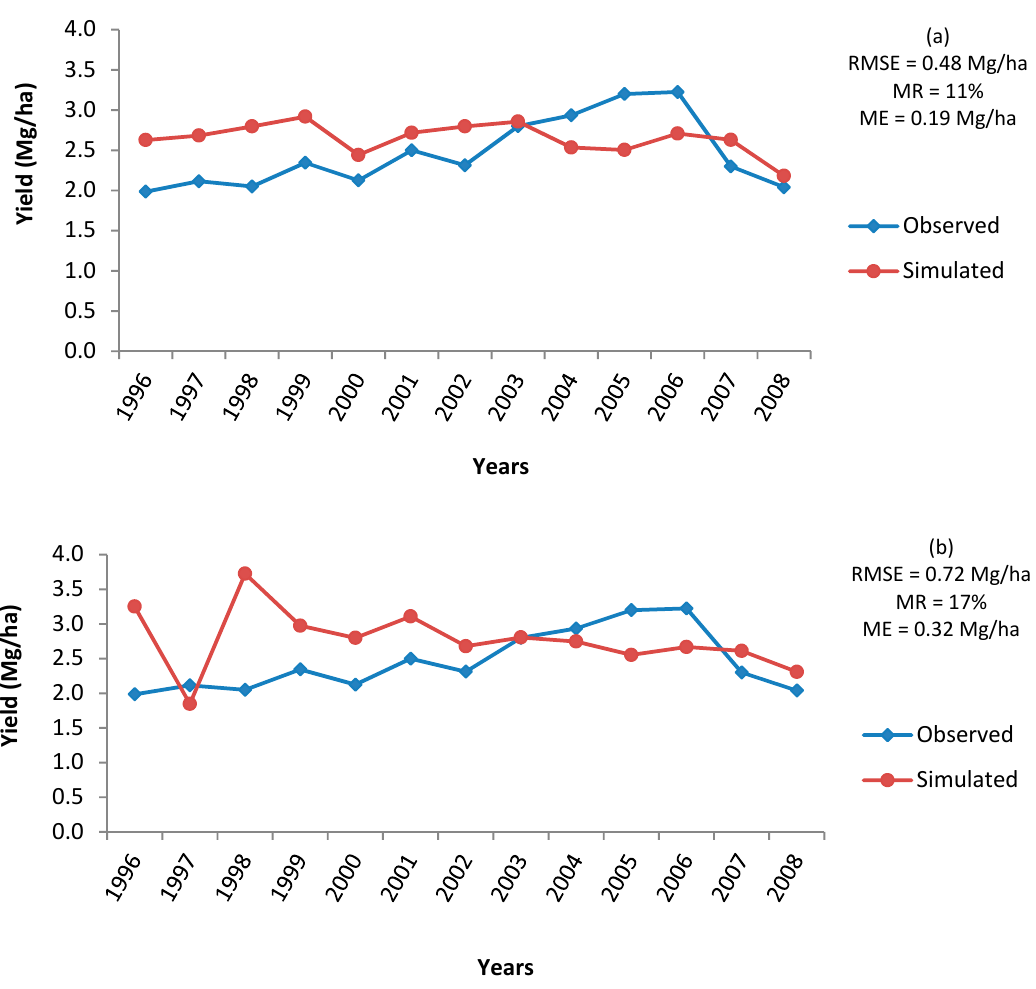
Figure 5. Comparison of observed and simulated maize yield in Oromia region in Ethiopia for 13 years (1996–2008) using weather data under Approach 1 (where data were obtained from a single source) ( a ), and Approach 2 (where data were obtained from different sources) ( b ).